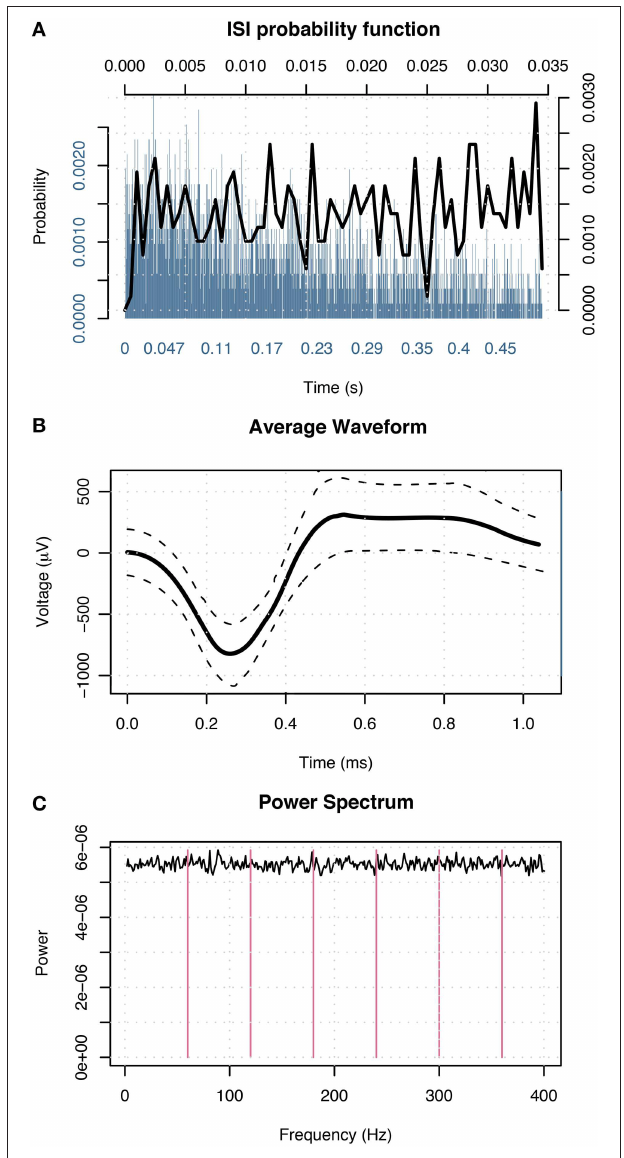
FIGURE 3 | Events in a cluster in the left amygdala of a male classified as single-unit activity. (A) Distribution of interspike intervals over two duration scales: broad range 0–0.5s (blue) and narrow range 0–0.035s (black) shown on x-axis. The y-axis designates probability of interval. (B) Average waveform shape. Time (ms) is shown on the x-axis. The y-axis denotes scale in µ V. The dashed lines indicate 1 SD at each sample point. (C) Power ± spectral density of event times. The x-axis displays frequency in Hz; magenta lines indicate primary and harmonics of the power line frequency (60Hz). The y-axis shows power spectral density in events